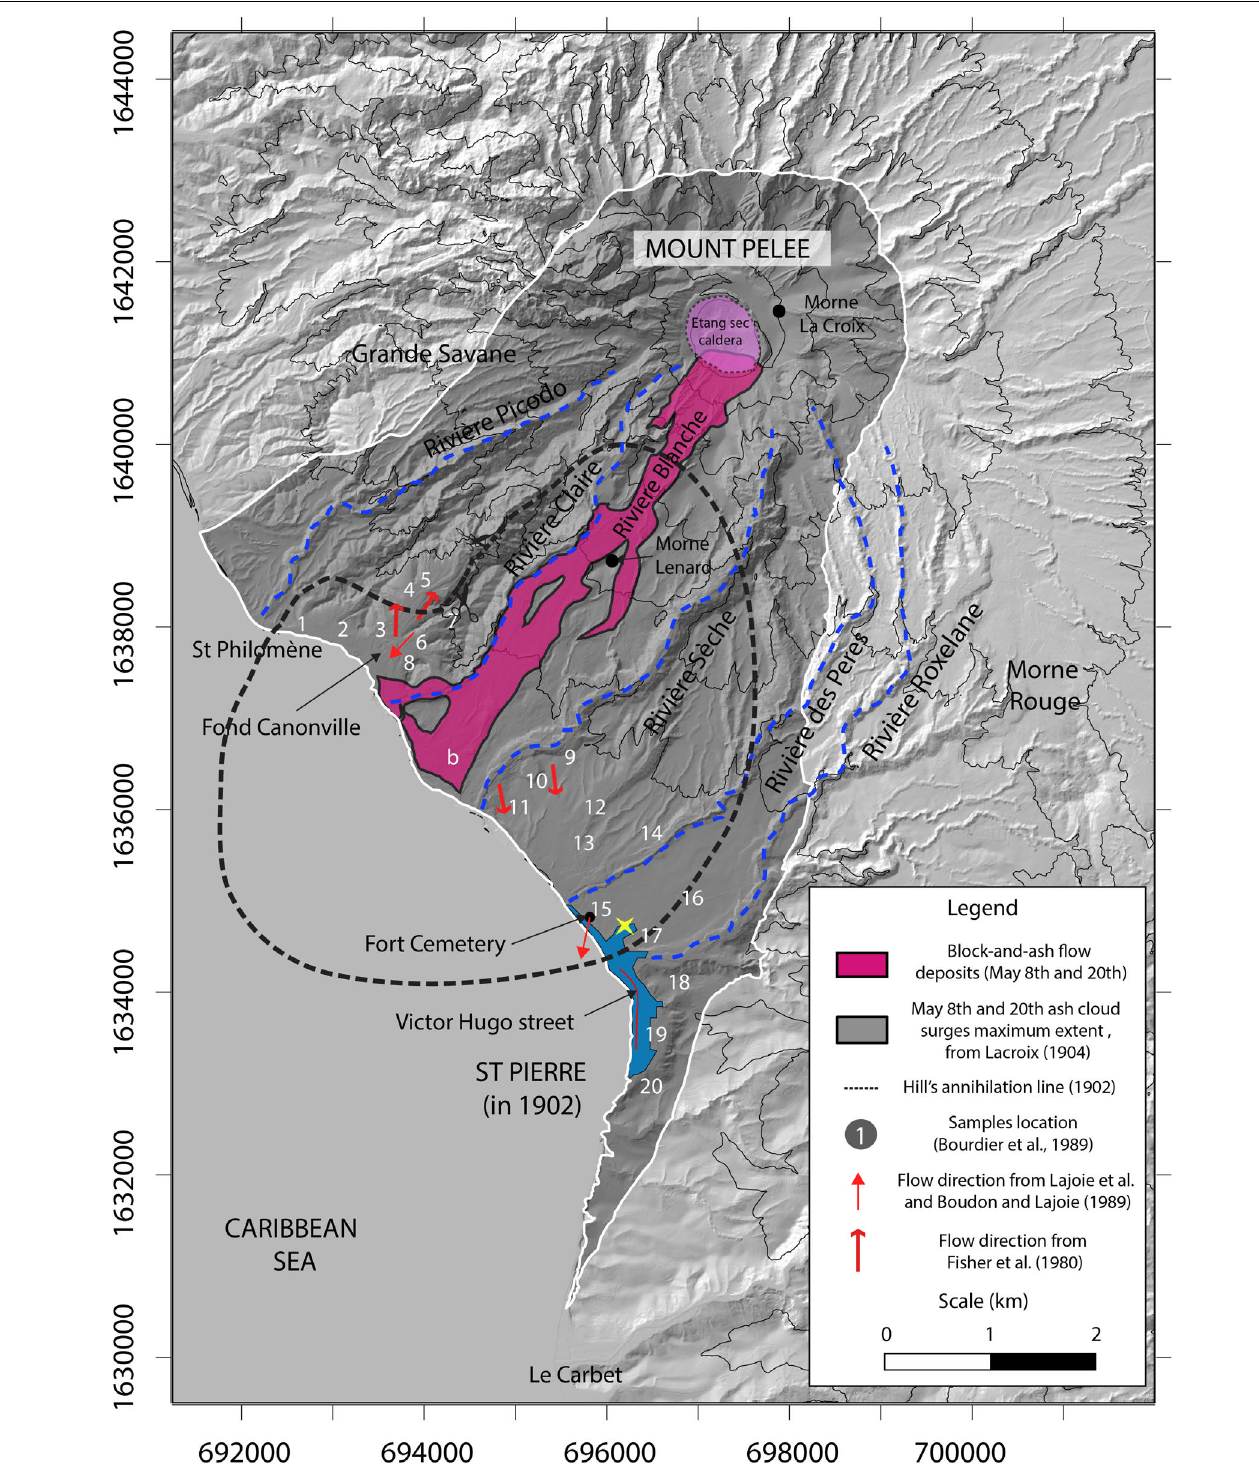
FIGURE 3 | Distribution map of the May 8th, 1902 eruption, with the ash-cloud surge and the block-and-ash flow inundated areas shown in gray and pink, respectively (modified after Bourdier et al., 1989; Hill, 1902; Lacroix, 1904; and BRGM Geological map). Main rivers are marked by blue dashed lines. The Hill’s annihilation line is represented by a black dotted circle. The pre-eruptive extent of the city of St Pierre is represented by the blue area. Current direction from Fisher and Heiken (1982), and Boudon and Lajoie (1989) – Lajoie et al. (1989) are represented by thick and thin red arrows, respectively. The location of samples used in this study are represented by the white numbers (from Bourdier et al., 1989).